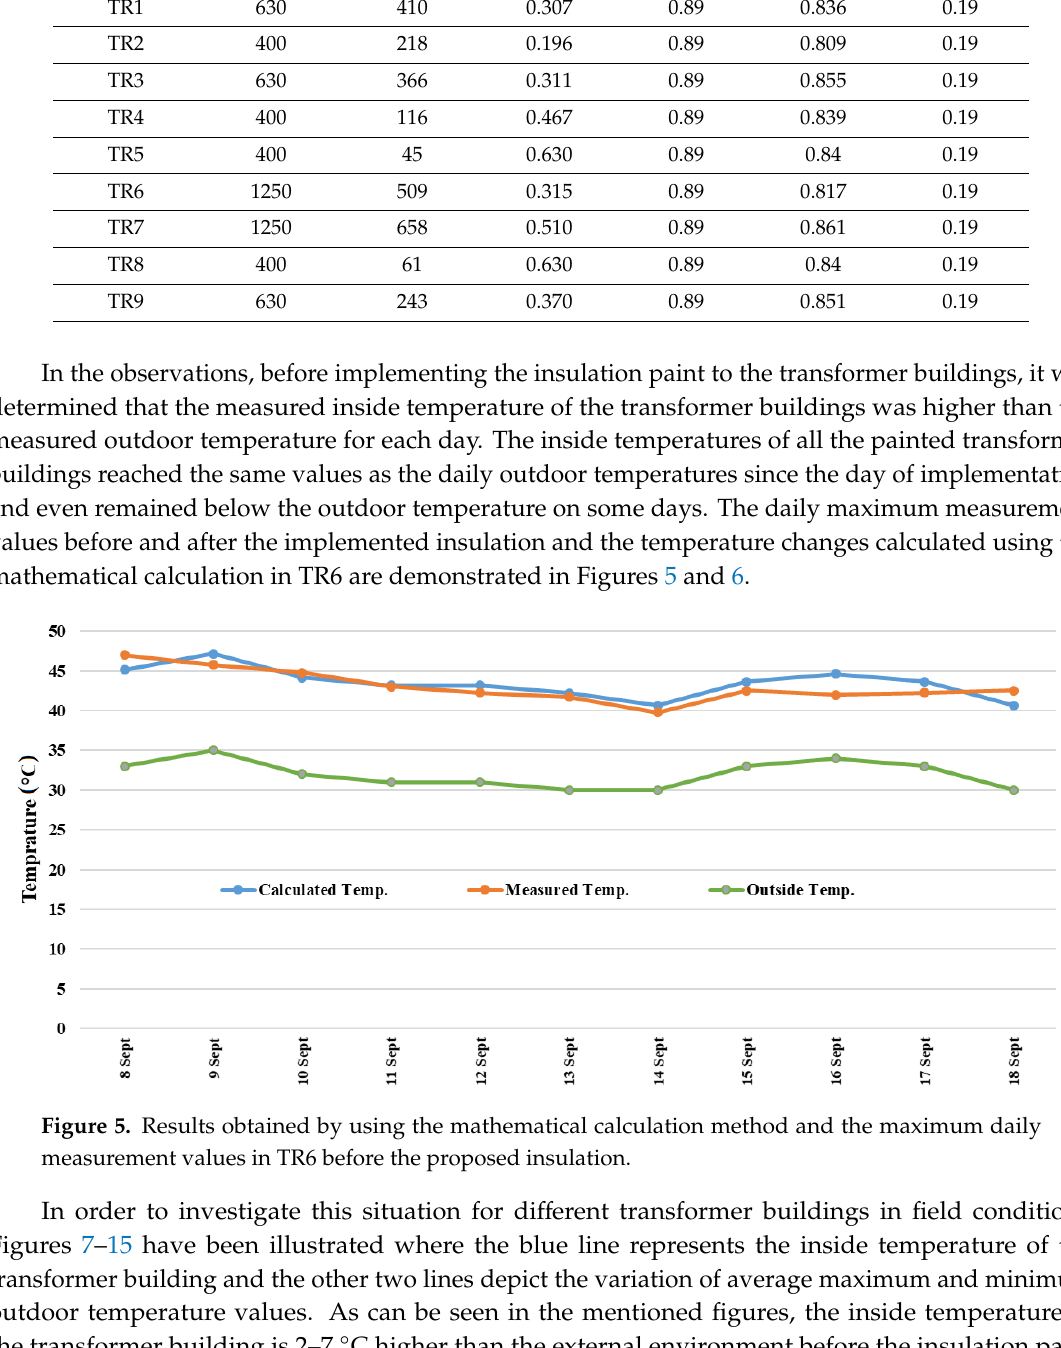
Figure 3. Reflectivity valued before and after the reflective coating.